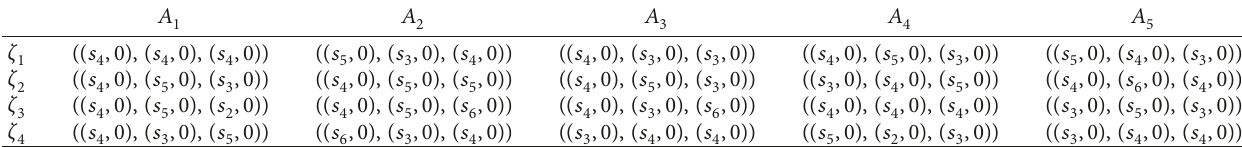
Table 2: Decision matrix for 2TL3F information.